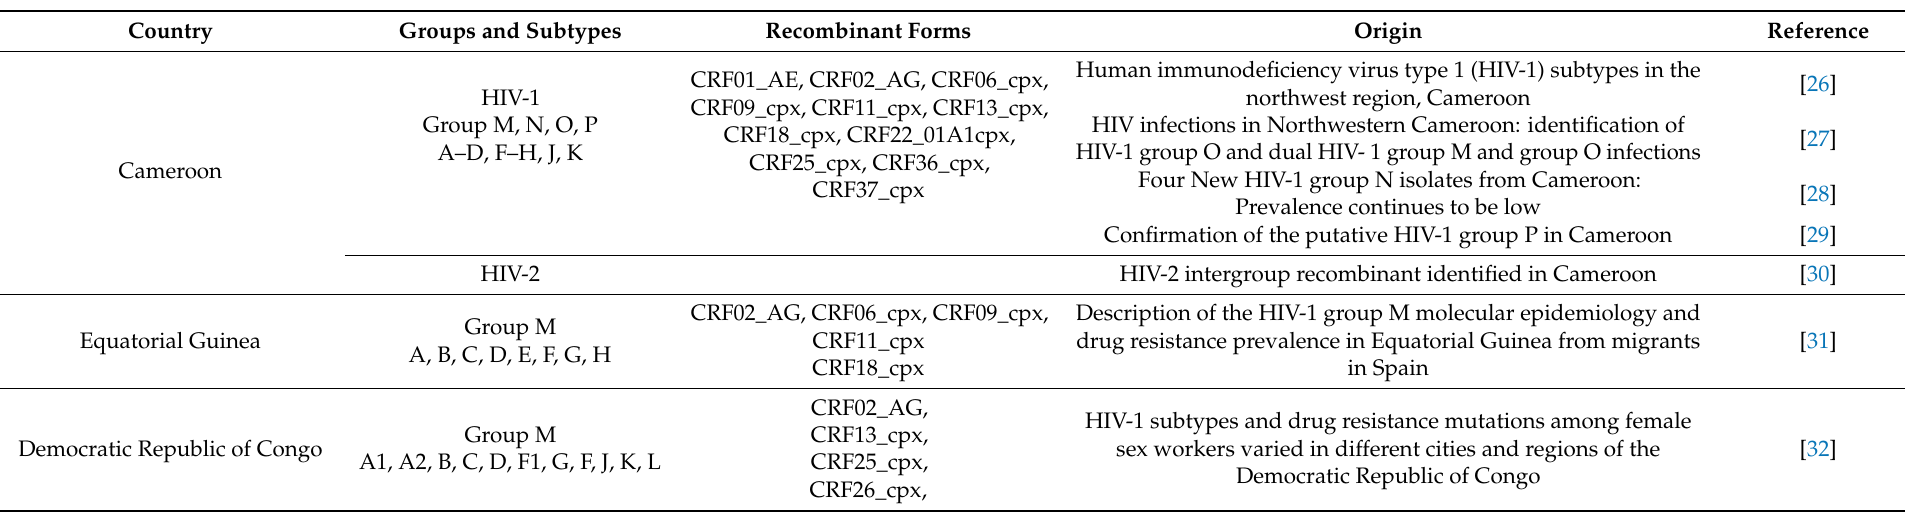
Table 1. Genetic diversity of HIV around